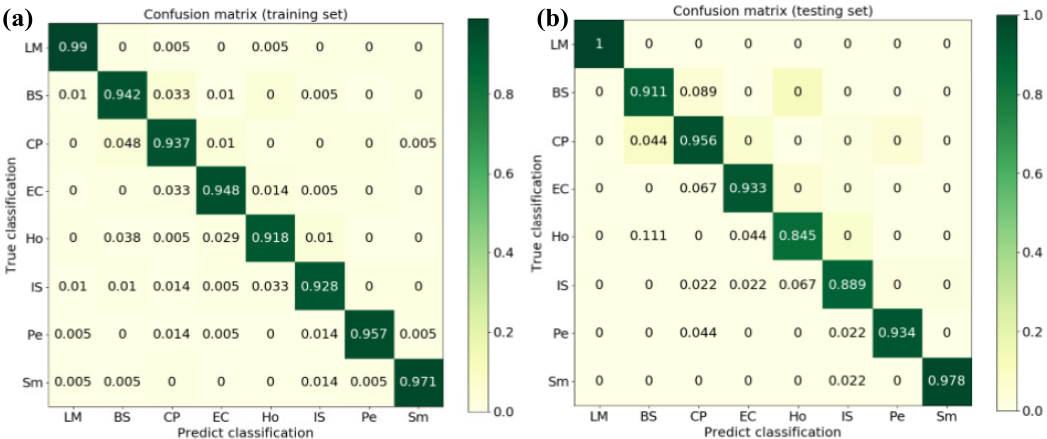
Figure 13. Confusion matrix of the training and testing sets by the proposed model: ( a ) training set, ( b ) testing set.